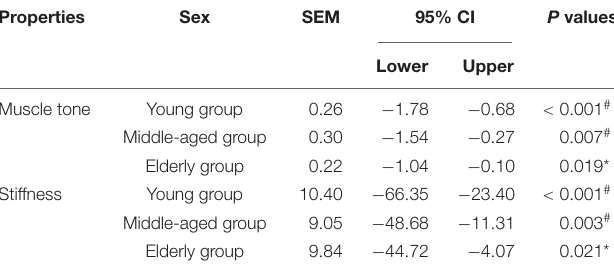
TABLE 5 | Statistical results of paired-samples T